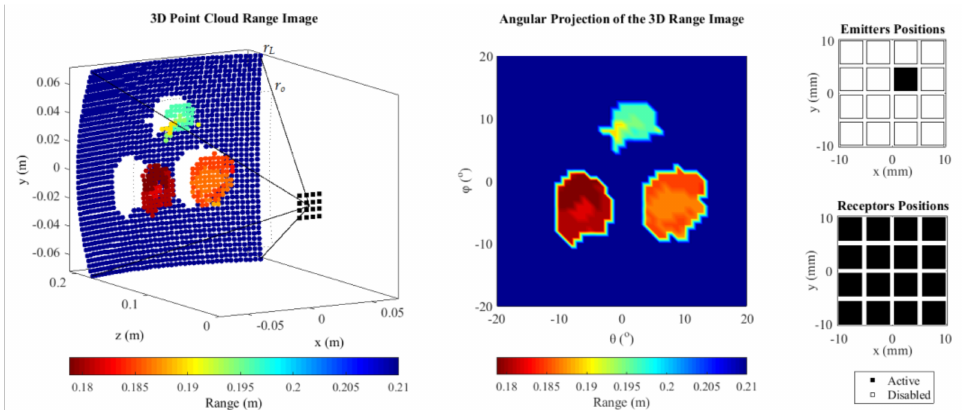
Figure 19. Images formed with all echoes generated by the emission of one element (m = 2, n = 3) and threshold of − 20 dB.